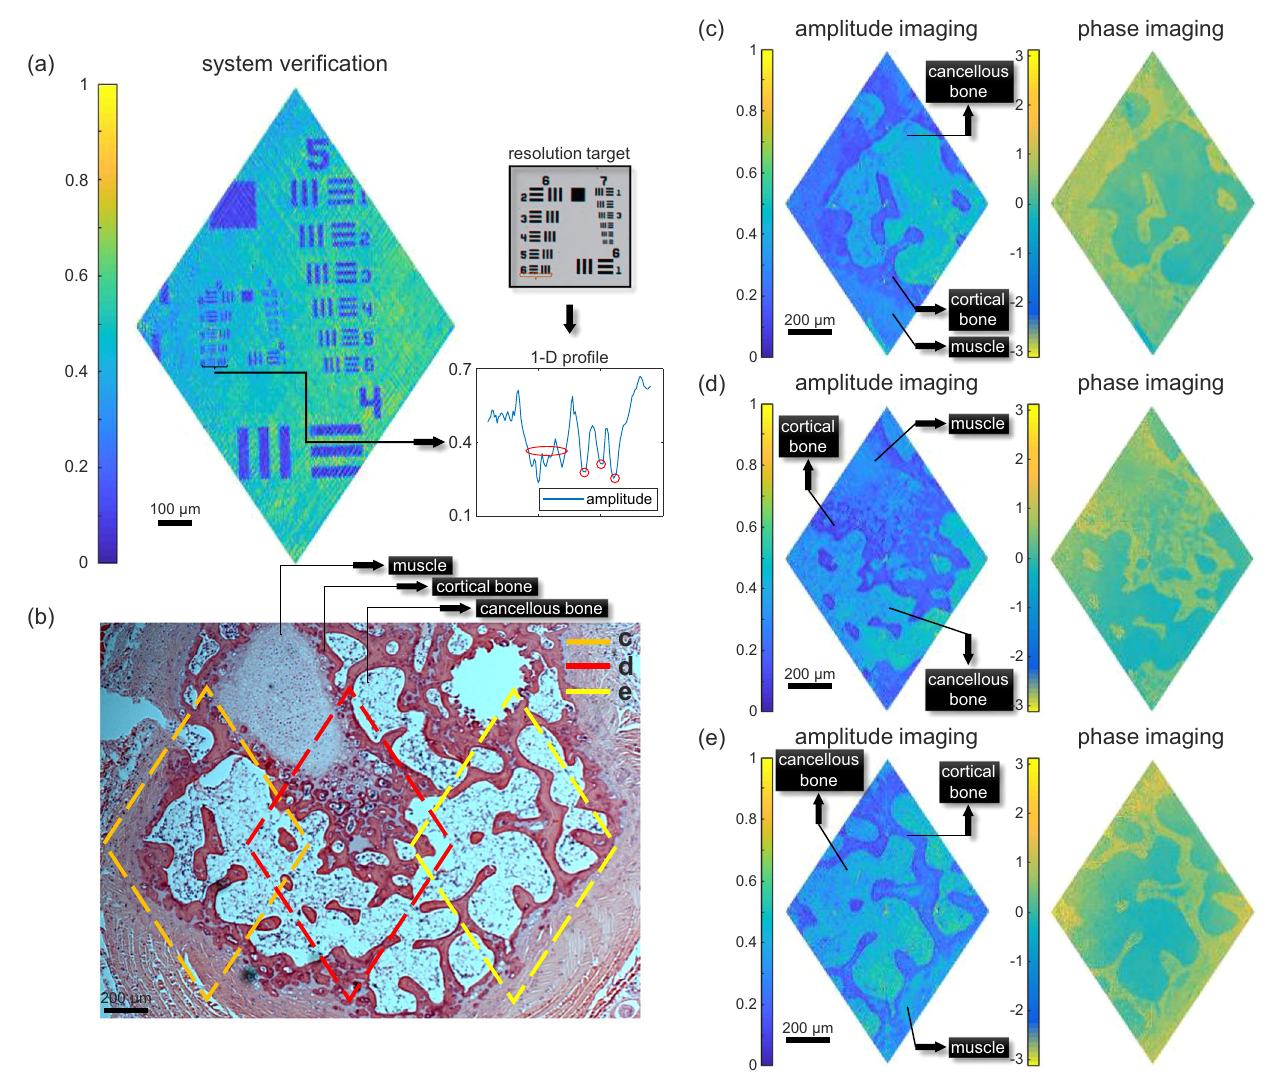
Fig. 2 Performance of the high-throughput SPH with stained tissue from mouse tails in high-resolution mode. a Reconstructed amplitude image of a resolution target. The upper inset: the image of the resolution target (containing groups 6 and 7) captured by a conventional microscope; the lower inset: the corresponding 1D pro fi le of element 6 of group 6. b The image of a slice of stained tissue from mouse tails, captured using a conventional microscope. Three diamond-shaped boxes represent the area being measured by the holographic system. c – e The reconstructed amplitude and phase images for different parts of the stained tissue. The corresponding scale bar is 200 μ